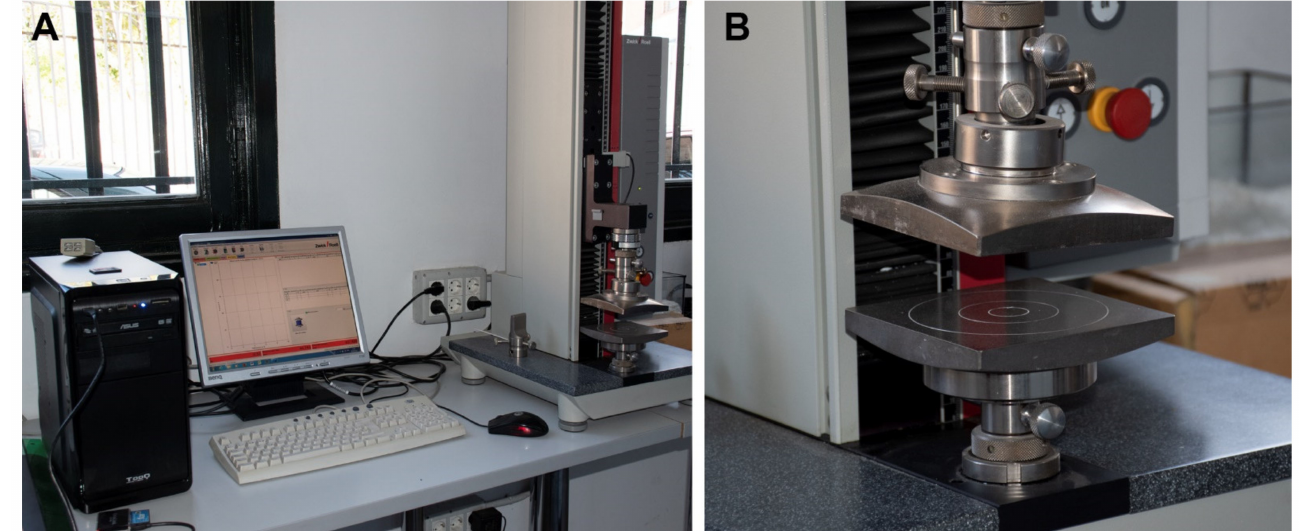
Figure 1. Uniaxial compression (Zwick/Roell Z5.0 TN) equipment. ( A ) Image of the equipment. ( B ) Detail of the load